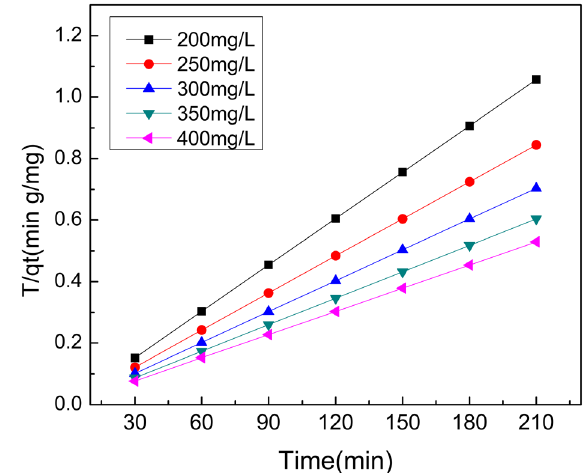
Figure 5: Pseudo-first-order kinetics for adsorption of methylene blue onto AC at 298 K.